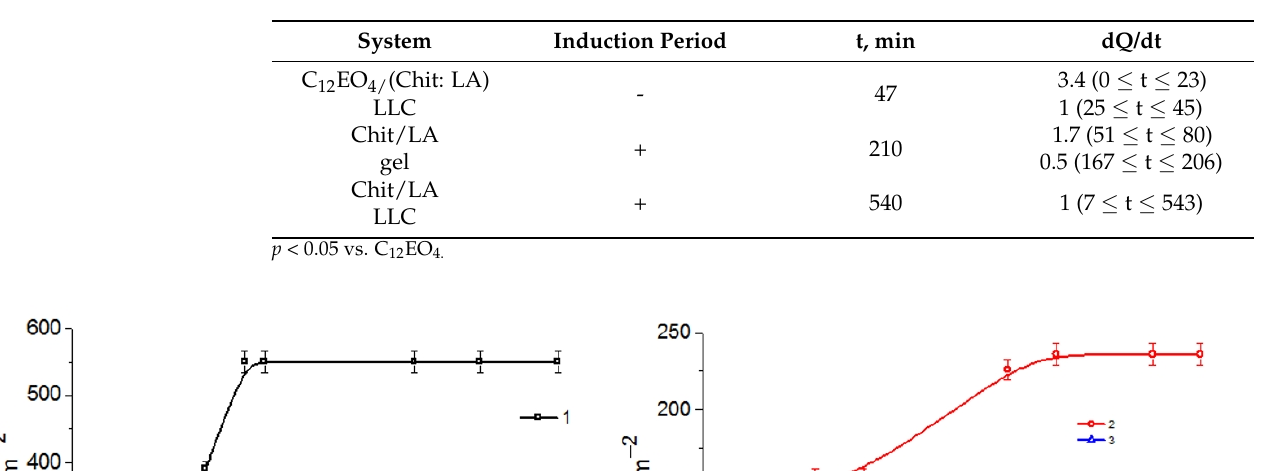
Table 2. Parameters of riboflavin mass transfer.